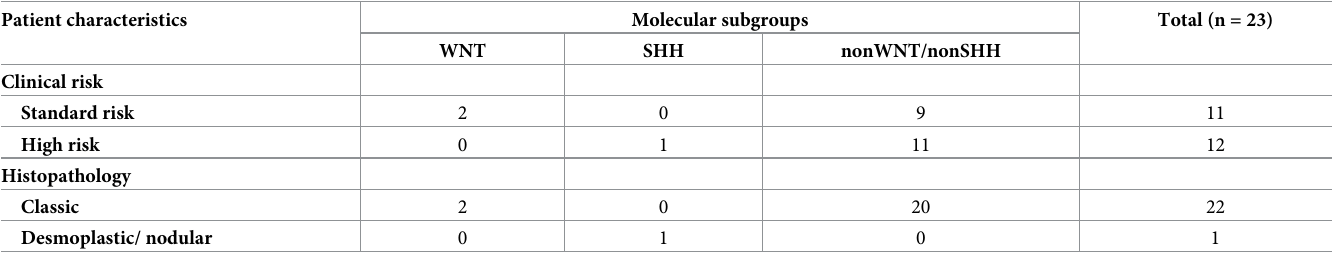
Table 3. Molecular classification of the medulloblastoma pediatric